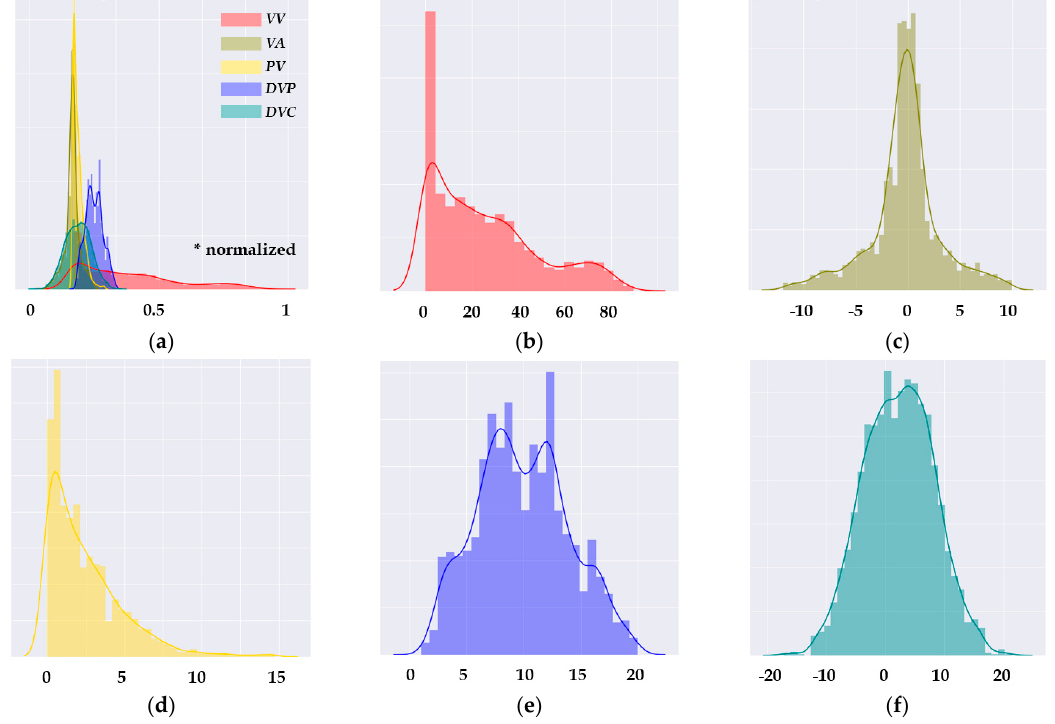
Figure 7. Histograms of ( a ) all features; ( b ) VV; ( c ) VA; ( d ) PV; ( e ) DVP; and ( f ) DVC.